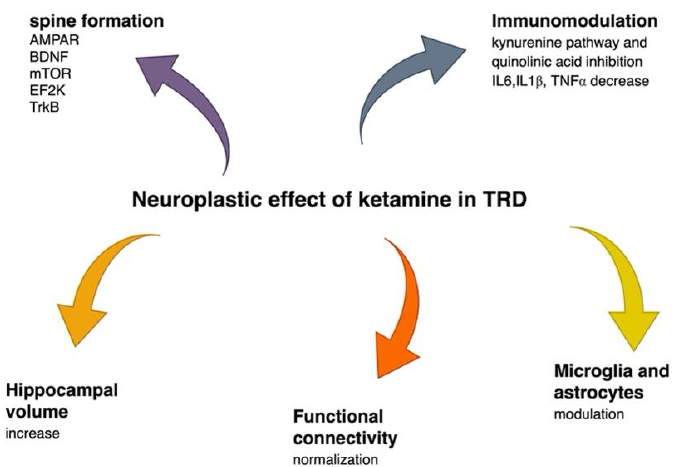
Figure 3. Ketamine’s neuroplastic effect in treatment-resistant depression. AMPAR— α -amino-3- hydroxy-5-methyl-4-isoxazolepropionic acid receptor, BDNF—brain derived neurotrophic factor, m- TOR—mammalian target of rapamycin, EF2K—eukaryotic elongation factor 2 kinase, TrkB—tyrosine receptor kinase B, IL6—interleukin 6, IL1ß interleukin 1 beta, TNF α —tumor necrosis factor α .